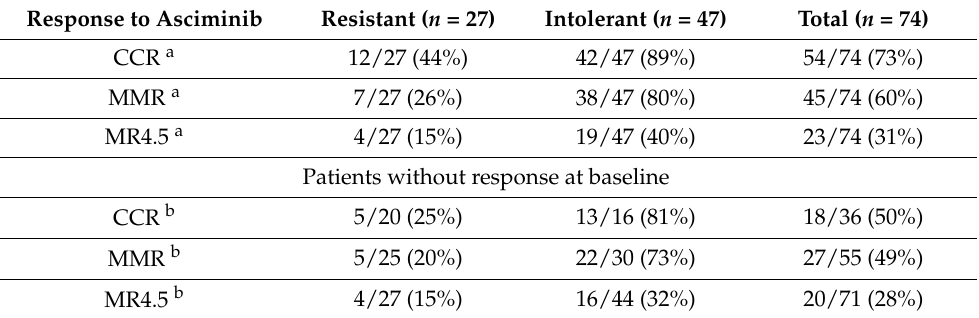
Table 3. Grades of overall responses to asciminib taking into account intolerance vs. resistance. CHR, complete hematological response; CCR, complete cytogenetic response; MMR, major molecular response; MR4.5, detectable disease with BCR::ABL1IS < 0.0032%. a Probability of achieving or maintaining previous response. b Patients without response at baseline. Response to